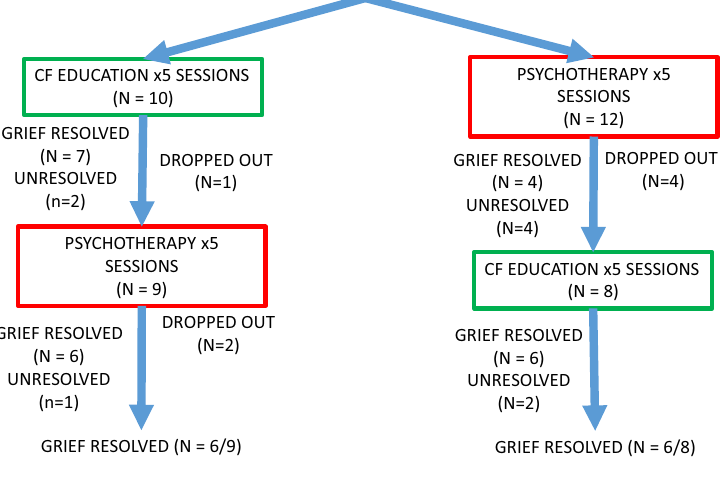
Figure 1. CONSORT